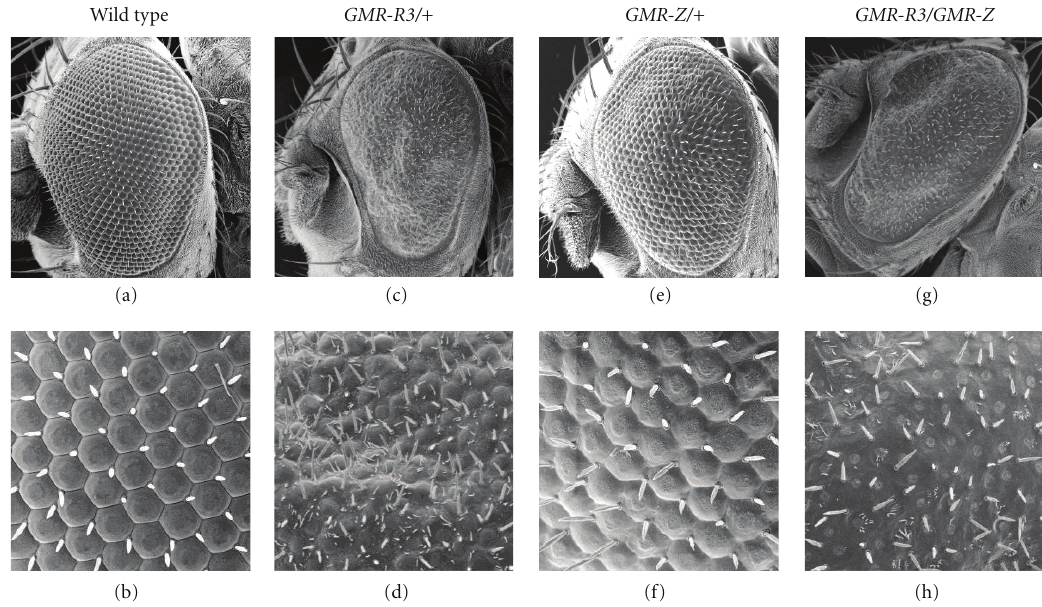
Figure 6: BZLF1 expression alters the GMR-R phenotype. A cross was performed between GMR-R and GMR- Z flies. SEMs were taken at 500x (top panels) and 2000x (bottom panels). Wild-type (a, b), GMR-R3/+ (c, d), GMR- Z /+ (e, f), and GMR-R/GMR- Z (g, h) adult eyes are